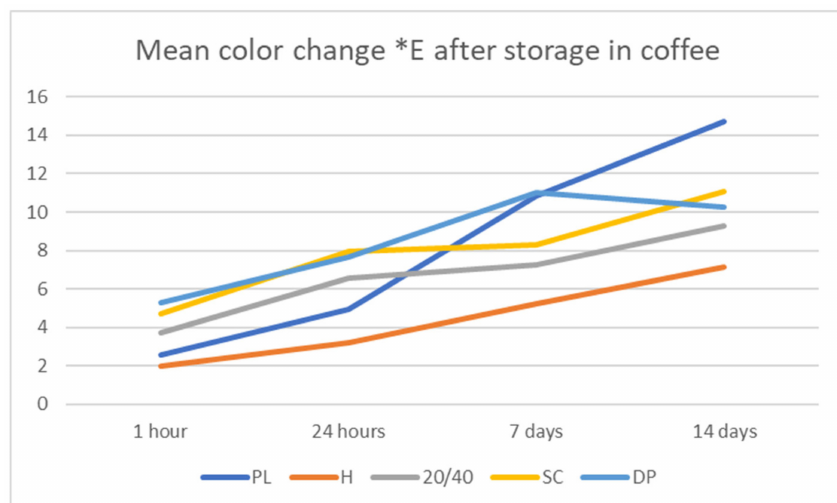
Figure 3. Mean color change ∆ E* after storage in coffee.